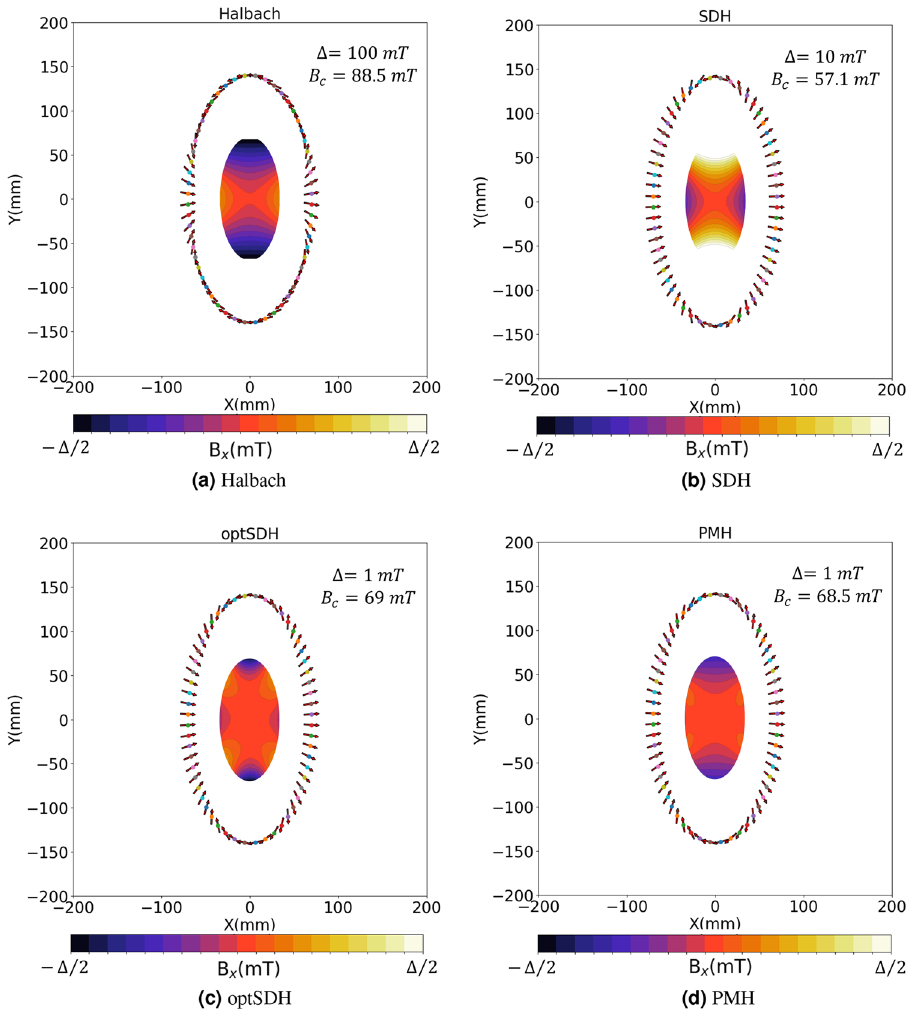
Figure 2. Magnetic field density map with magnetic flux lines for elliptical magnets with ellipticity, ε = 0.5 and elliptical ROI for ( a ) Halbach, ( b ) SDH, ( c ) optimized SDH and ( d ) PMH rotation rules. (cid:31) and B c are the width and the central magnetic field values of the colorbar in the field density